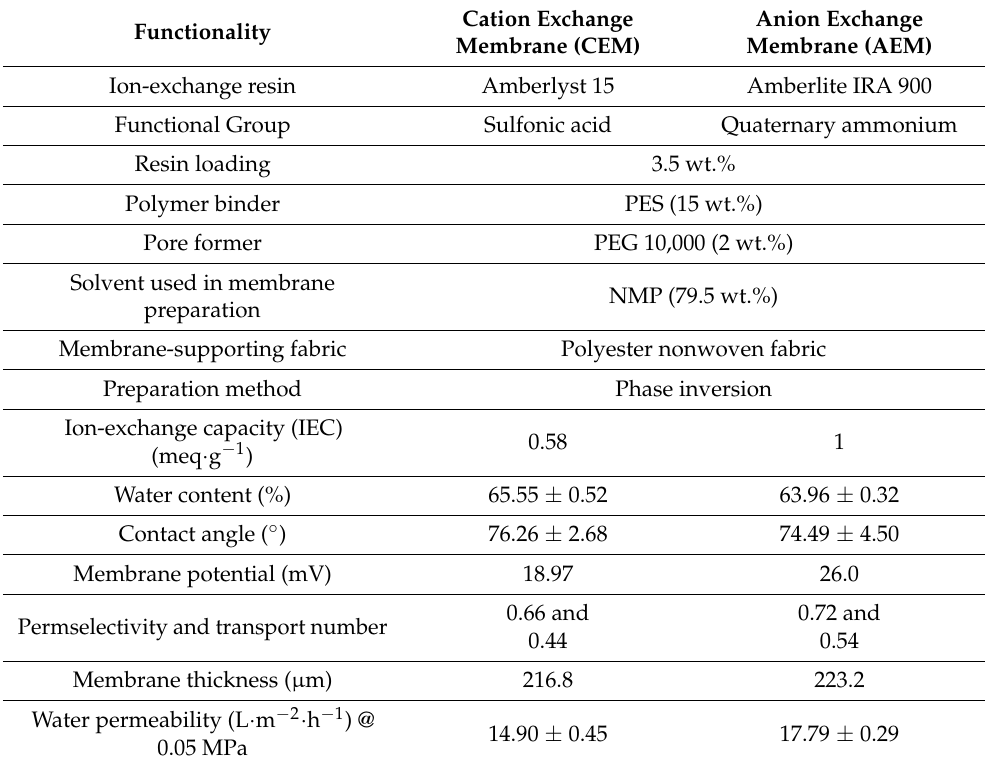
Table 1. Technical specifications of custom-made ultrafiltration heterogeneous ion-exchange